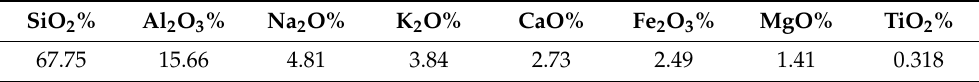
Figure 1. Granite specimens. Table 1. Granite mineral content.